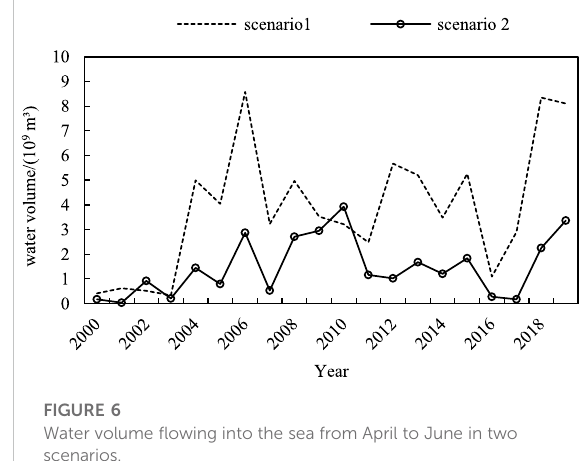
FIGURE 6 Water volume fl owing into the sea from April to June in two scenarios.